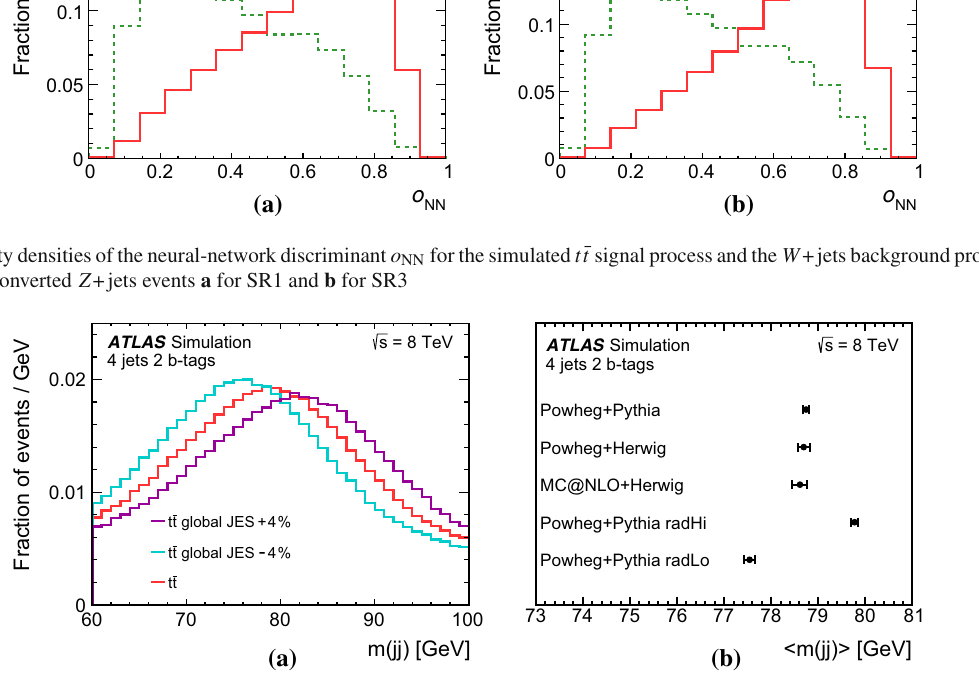
peak. b Mean value of the fit to the m ( jj ) distribution using a Gaus- siandistribution for different signalgenerator set-ups. The uncertainties shown are statistical only